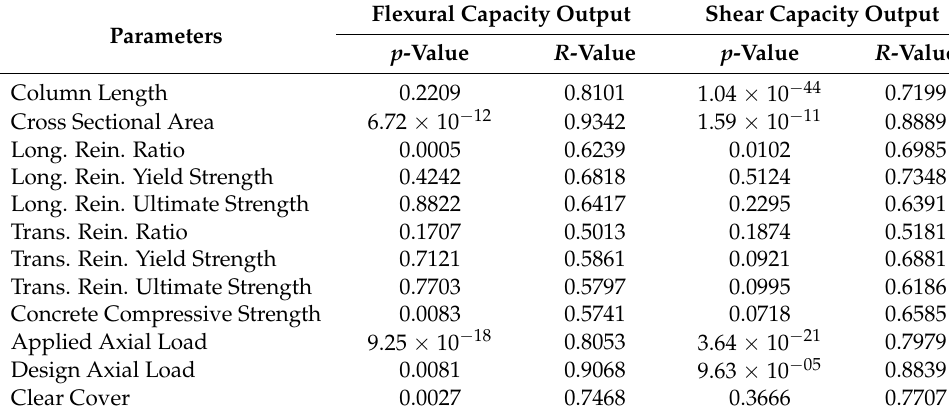
Table 2. Parametric Selection Based on Linear Regression and Cosine Amplitude.